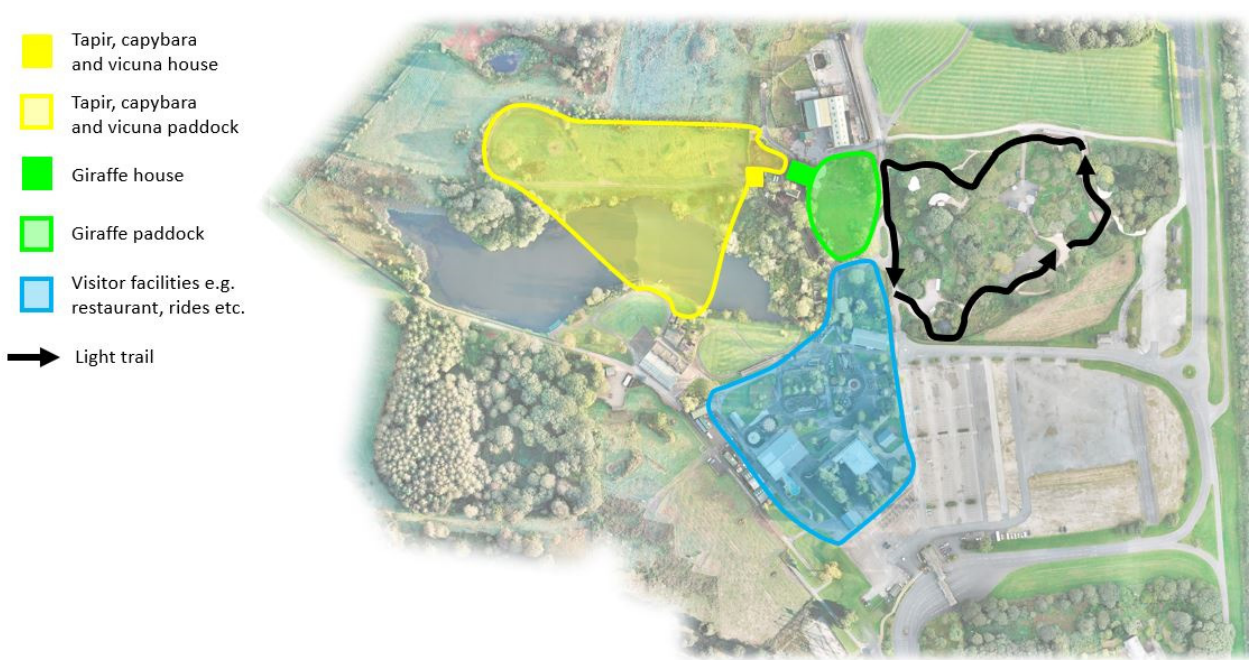
Figure 1. Map of the event space at Knowsley Safari. Areas featured in the present study are shaded and the light trail is marked, including recommended direction of travel. Visitors have access to the light trail and the blue area with visitor facilities. CCTV cameras were located in the houses of each species, and did not cover either paddock.